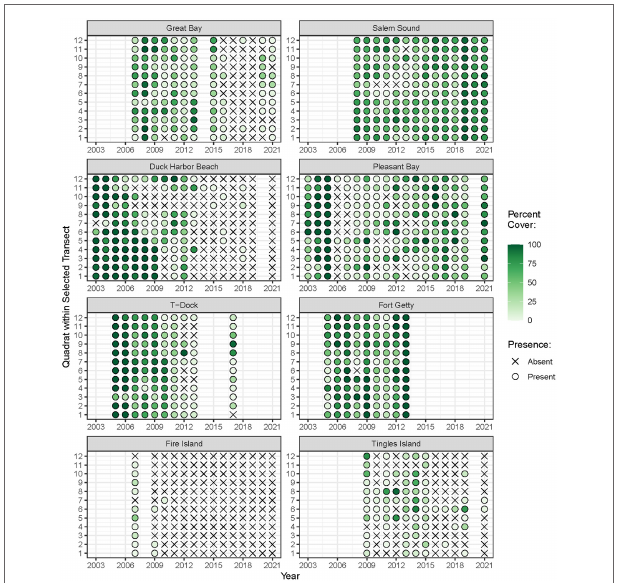
FIGURE 2 | Monitoring years and percent cover of eelgrass ( Zostera marina L.) within each quadrat over time. Absence of plant cover is depicted with an ×